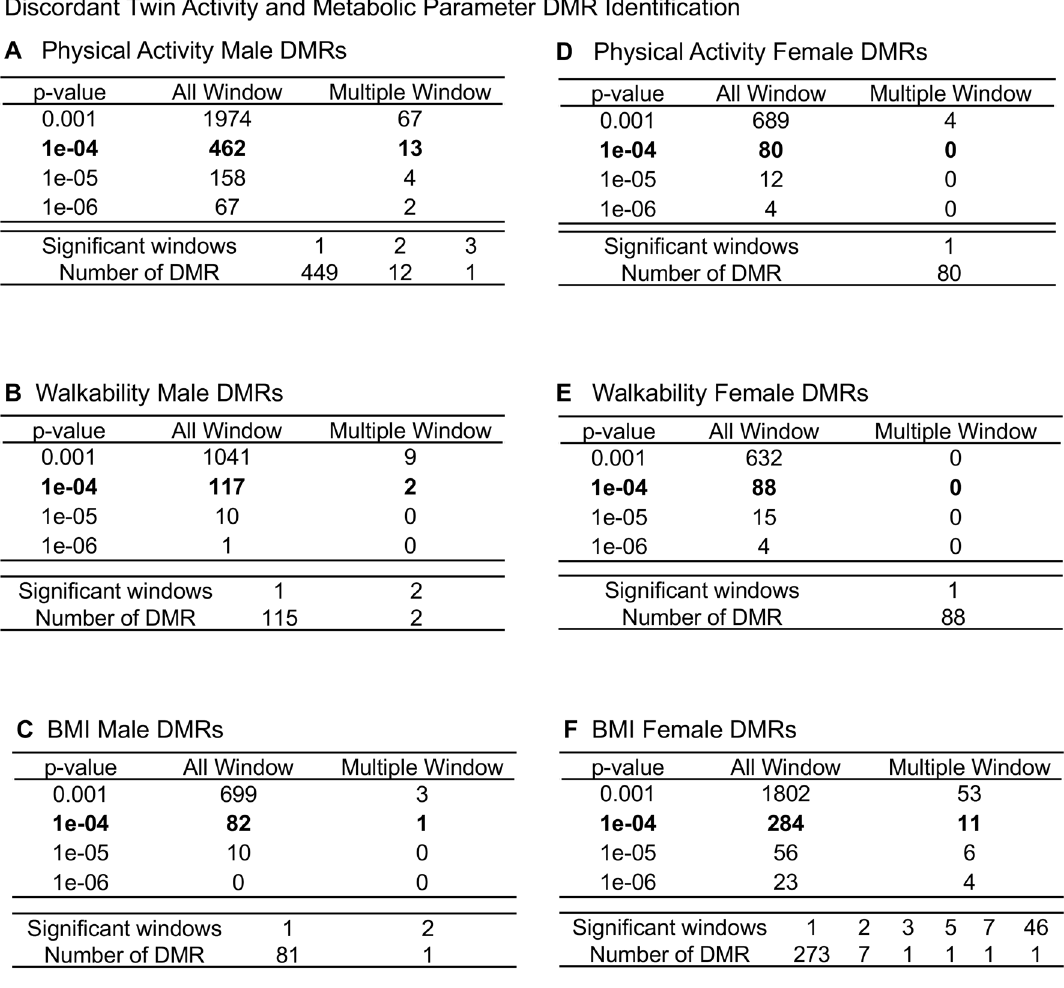
Figure 1. Discordant twin activity and metabolic parameter DMR identification. The number of DMRs found using different p value cutoff thresholds. The All-Window column shows all DMRs. The Multiple Window column shows the number of DMRs containing at least two nearby significant windows (1 kb each). The number of DMRs with the number of significant windows (1 kb per window) at a p value threshold of p < 1e−04 for DMR is bolded. ( A ) Activity male DMRs; ( B ) Walkability male DMRs; ( C ) BMI male DMRs; ( D ) Activity female DMRs; ( E ) Walkability female DMRs; and ( F ) BMI female